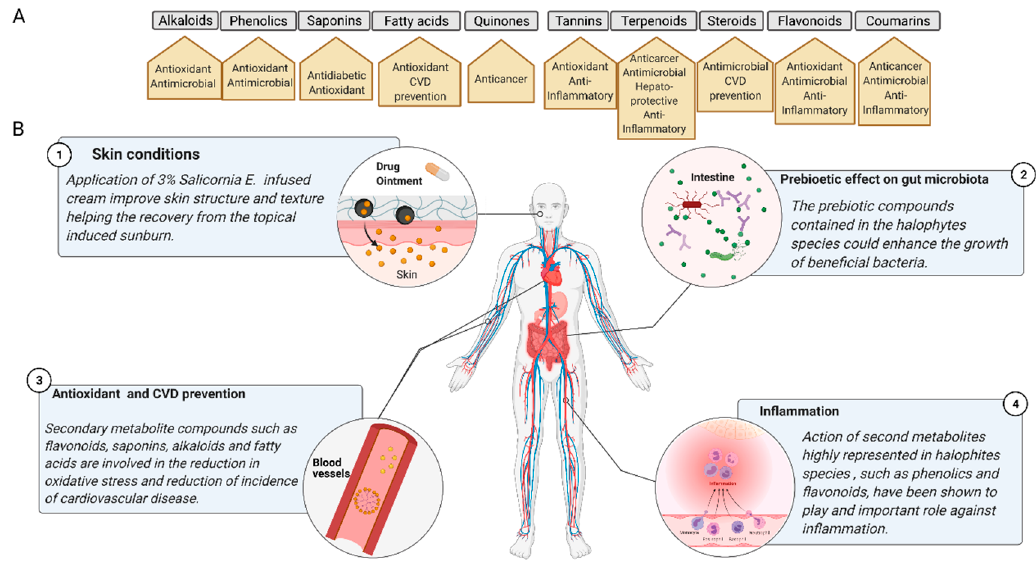
Figure 2. ( A ) Principal physiological processes that involve the action of secondary metabolites present in halophytic species. CVD, cardiovascular disease. ( B ) Main biomedical mechanisms of secondary metabolites’ activities of halophytes. Created with BioRender.com.